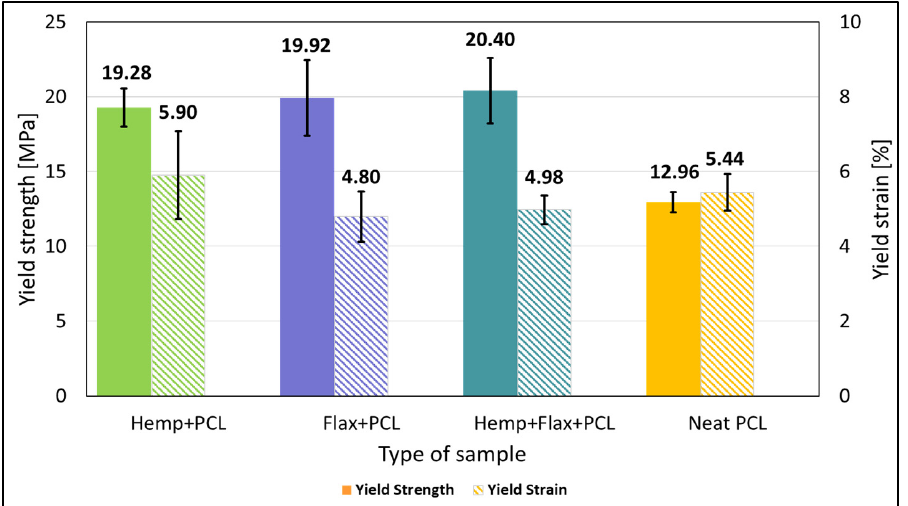
Figure 6. Yield strength and yield strain comparison of different samples.